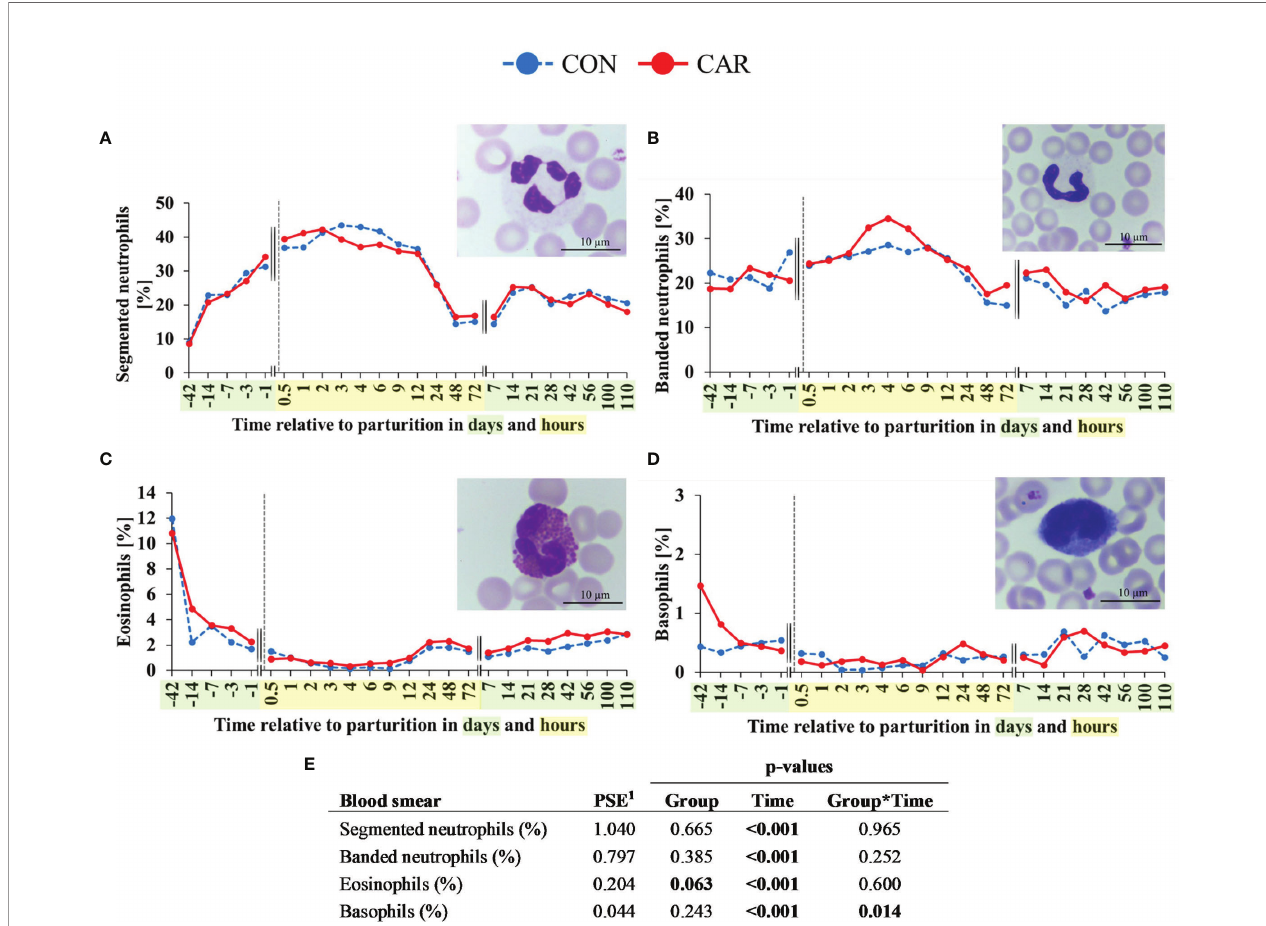
FIGURE 4 | Quanti fi cation and different maturation stages of peripheral granulocytes of dairy cows fed a diet supplemented with (CAR) or without (CON) L-carnitine from 6 weeks before until 15 weeks after calving. (A) segmented neutrophils, (B) banded neutrophils, (C) eosinophils and (D) basophils counted manually on stained blood smears. (E) Data statistics. Data are shown as least square means; representative microscopic images of different granulocyte subsets are included respectively. 1 pooled standard